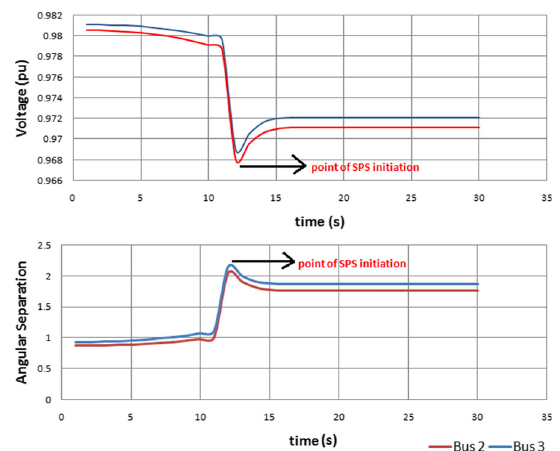
Fig. 16 Bus parameters on SPS